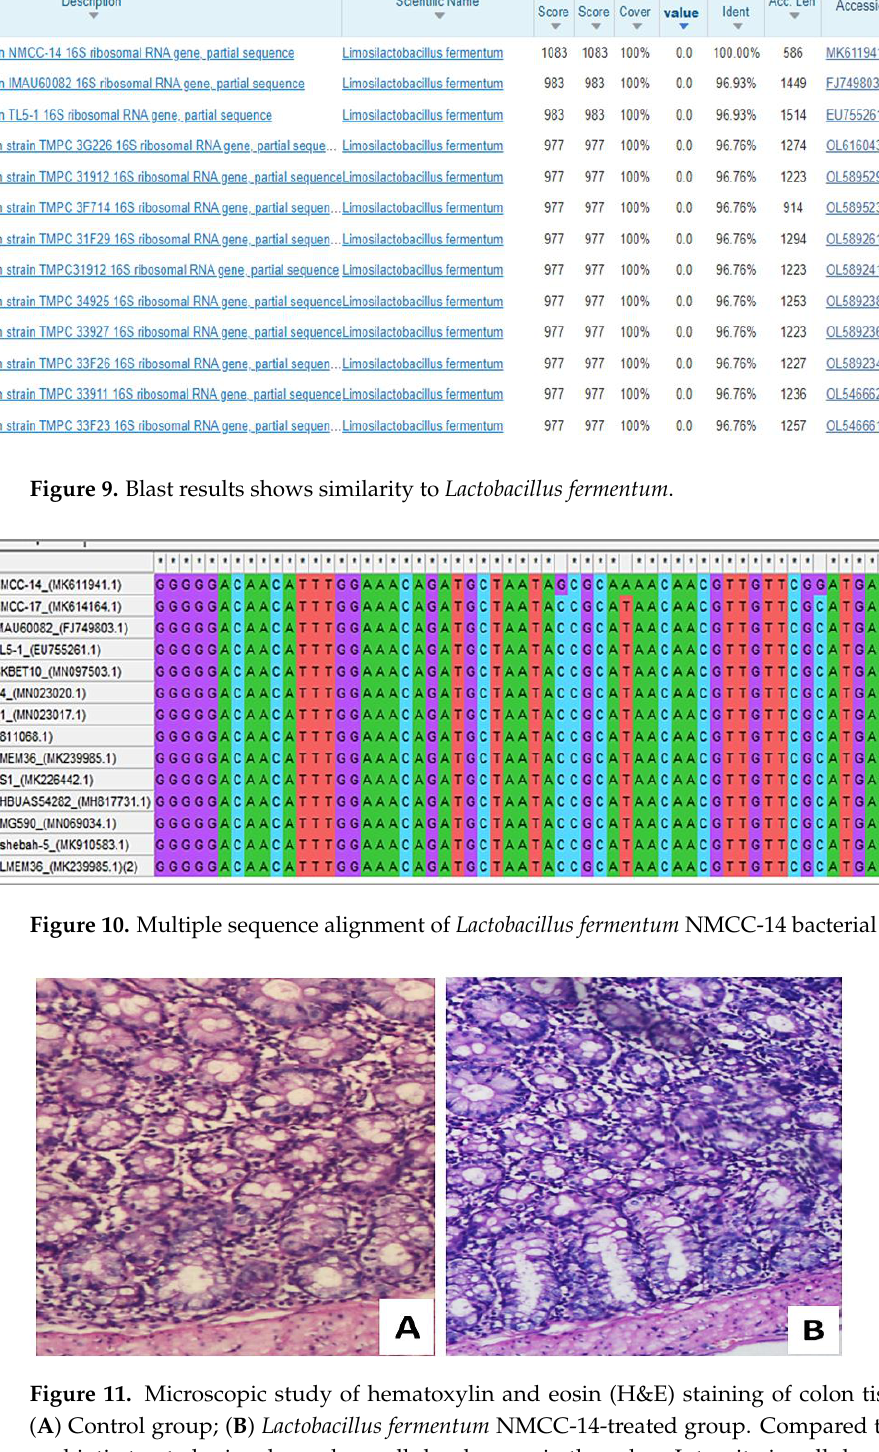
Figure 12. Cecal concentration of Lactobacillus fermentum NMCC-14 and E. coli in control and probi- otic-fed mice.